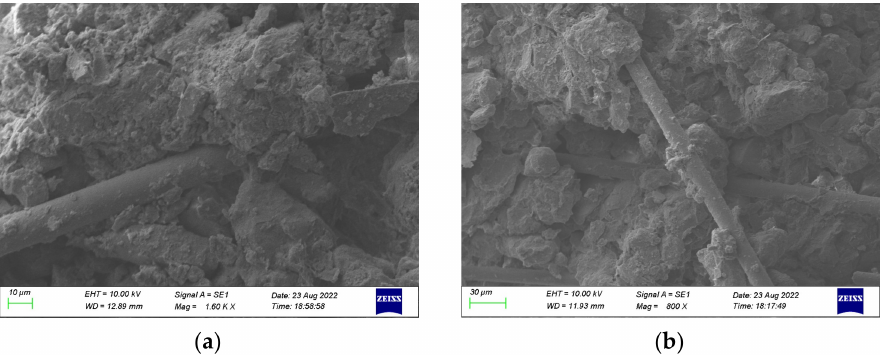
Figure 6. SEM images of fiber-reinforced loess: ( a ) anchoring effect; ( b ) bridging